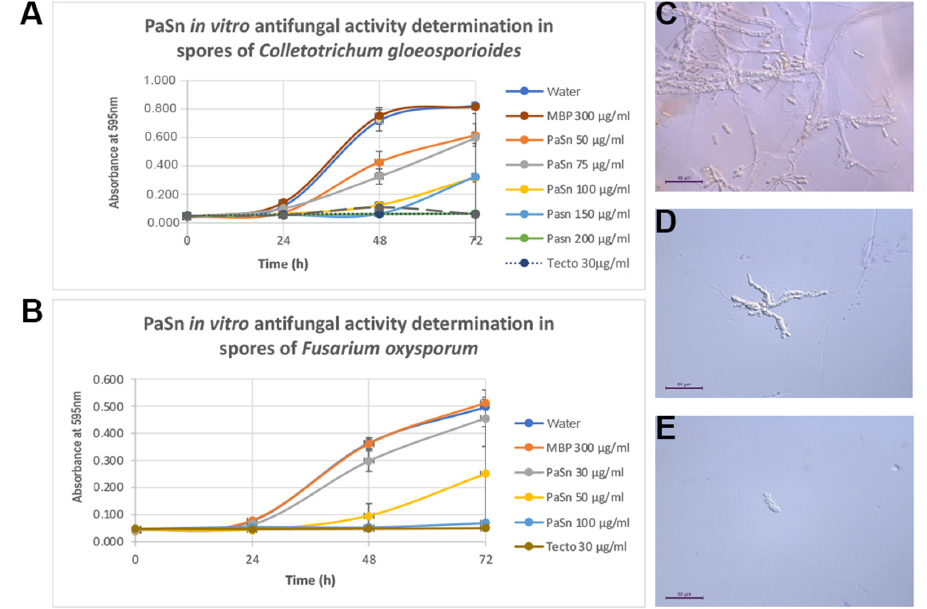
Figure 4. Phytopathogen spore germination. In vitro fungal phytopathogen spore germination was assessed using an MTT viability assay with different PaSn concentrations. ( A ) Colletotrichum gloeosporioides , and ( B ) Fusarium oxysporum . ( C – E ): C. gloeosporioides micrograph of spore germination alteration ( C ): Control negative, ( D , E ): PaSn 300 μ g/mL. Data were analyzed by ANOVA one-way and post hoc Tukey’s test ( p < 0.05).